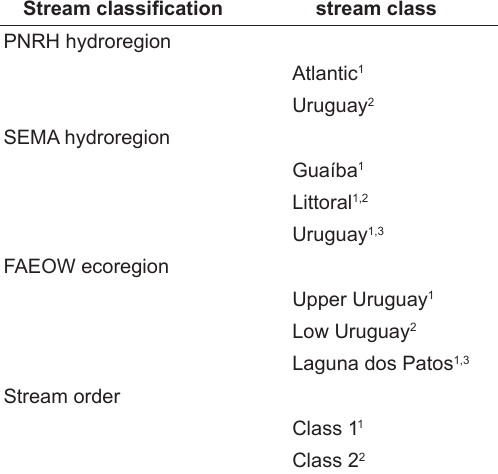
_ ). URU = Uruguay; ATL = Atlantic; Table 2. Environment variables differences among stream class within stream classifications. Environment variable groping is not showed. The similar superscript numbers indicates environment similarity. For an α = 0.05 and 10.000 randomizations (db-MANOVA).